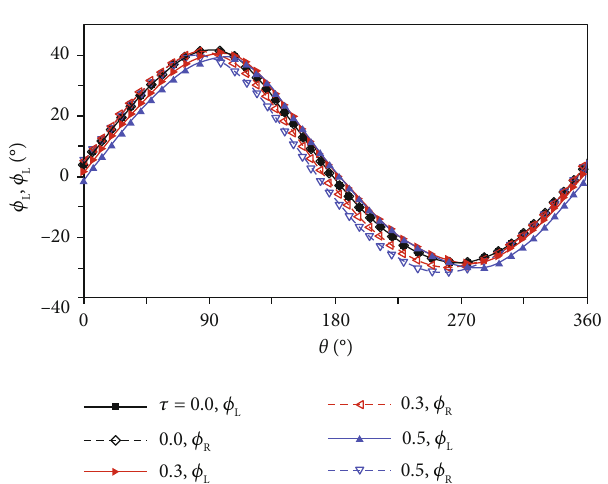
ϕ θ (DCRM). L and R versus